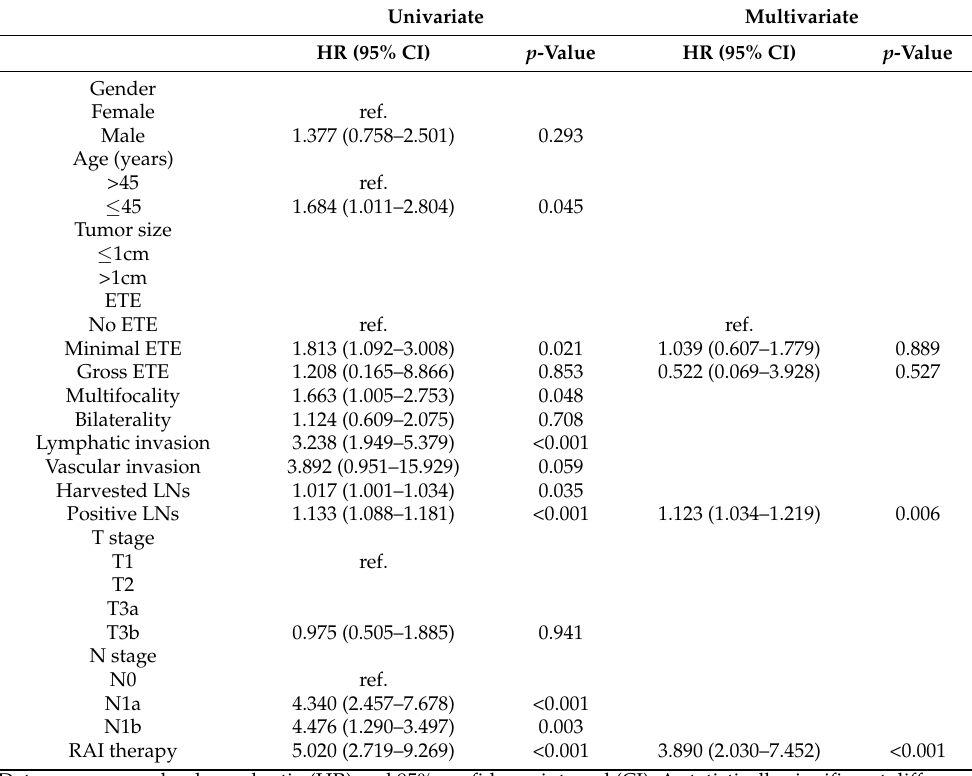
Table 6. Univariate and multivariate analyses of risk factors for recurrence in PTMC. Univariate